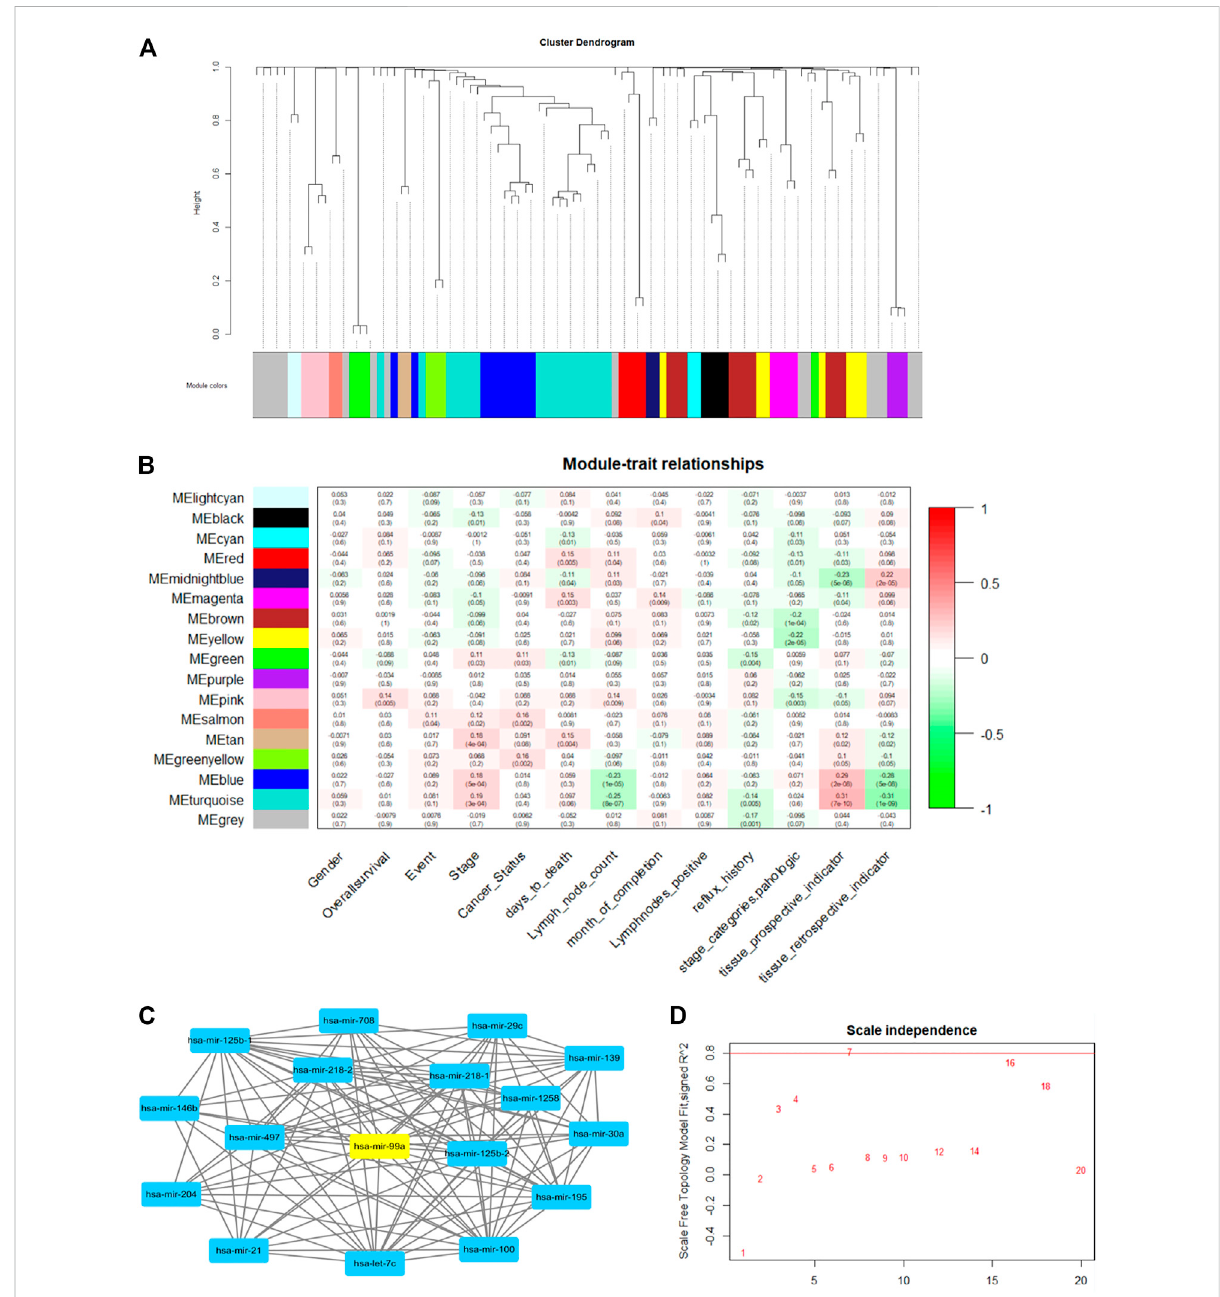
FIGURE 6 The example of WGCNA network analysis. (A) The gene cluster dendrogram. Genes are clustered into 17 modules, which are illustrated in different colors. (B) Module-trait relationships: there are 13 clinic traits. Module and trait relationships are illustrated in red and green. The red color shows that they are positively related, and the green color means they are negatively related. (C) Example of a gene topology graph in the turquoise module. The hub gene in this module (has-mir-99a) is highlighted in yellow. (D) gene-gene scale independence and module fi t relationship. The red line is the suitable threshold for module fi t. We chose power = 7 as the best factor, as a higher power value will make the gene topology graph